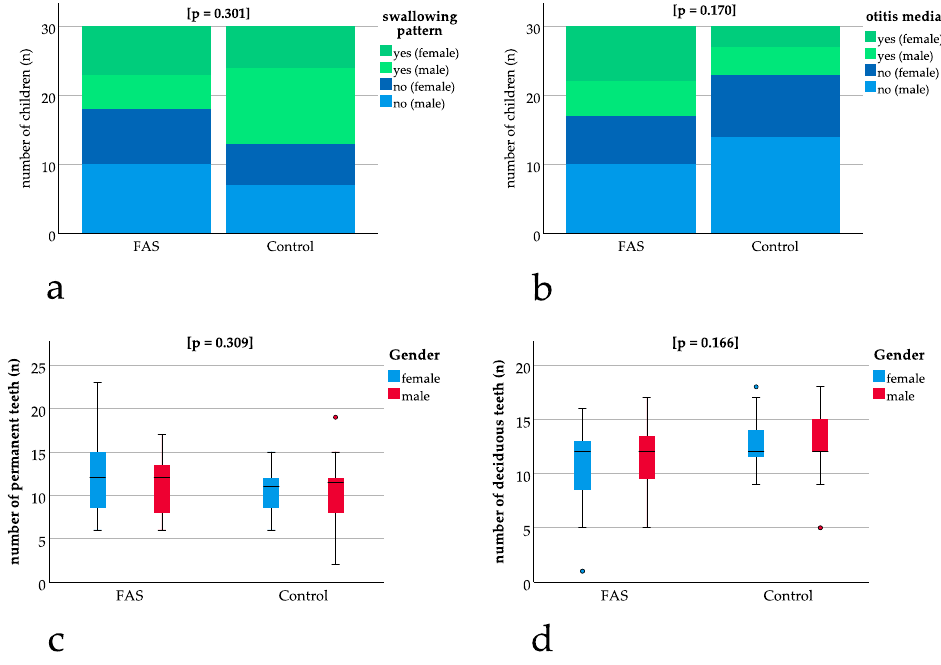
Figure 2. Comparison of children with FAS and controls: ( a , b ) bar charts with binary results (yes / no). Positive (“yes”) results are depicted in green (dark green female, light green male) and negative (“no”) results are depicted in blue (dark blue female, light blue male). Bar charts show non-significant di ff erences in swallowing pattern ( p = 0.301) and otitis media ( p = 0.170). ( c , d ) Box plots for non-significant di ff erences in the number of permanent ( p = 0.309) and deciduous teeth ( p = 0.166) thus enabling comparisons concerning dental parameters.